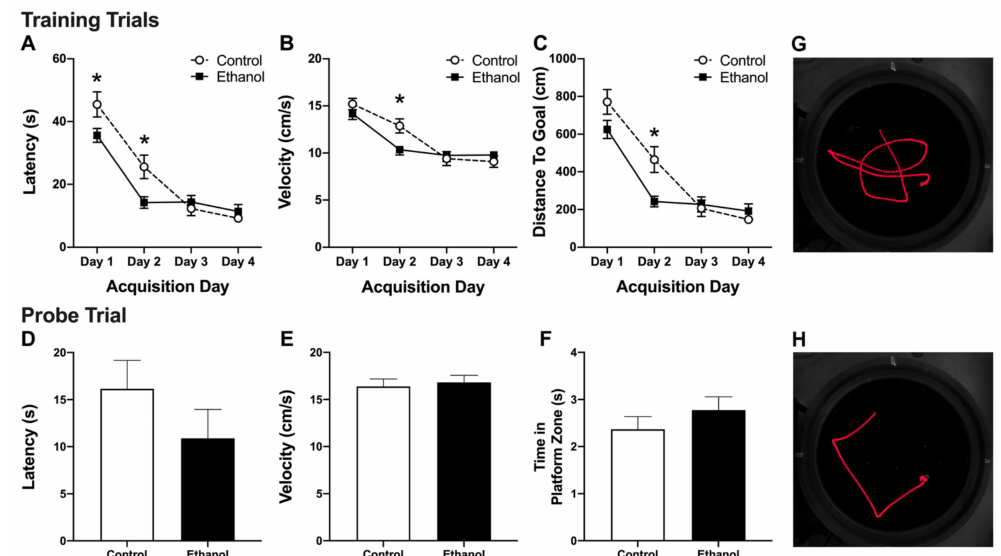
Figure 2. Morris water maze (MWM) performance: Two-way repeated measures analysis of the 4-day MWM training revealed a significant main effect of acquisition day and an acquisition day by alcohol experience interaction on ( A ) latency ( B ) swim velocity, and ( C ) distance travelled, but no main effect of prior alcohol exposure alone. Planned comparisons revealed significantly better MWM performance as assessed by latency, velocity, and distance travelled in the alcohol-treated group ( n = 10) compared to controls ( n = 11) on training days 1 (latency) and 2 (latency, velocity, and distance travelled). Symbols represent means for each day. On the fourth day following the MWM training trials, all animals underwent a probe test in which the platform was removed. Unpaired t-tests revealed no significant differences between the alcohol-treated animals and controls in the ( D ) latency to the platform area, ( E ) swim velocity, and ( F ) time spent in the previously learned platform zone. Representative MWM traces from a ( G ) control and ( H ) ethanol-treated rat on day 2 of acquisition. Bars represent means ± standard error of the mean (SEM). * p <